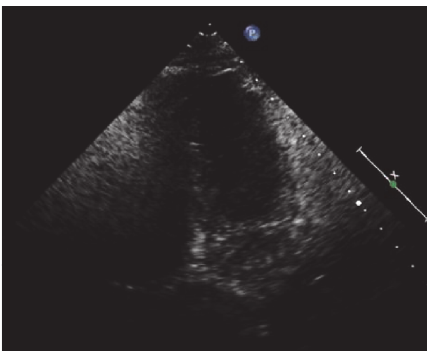
Figure 5: Mid-ventricular akinesis, end systole (postop pics).